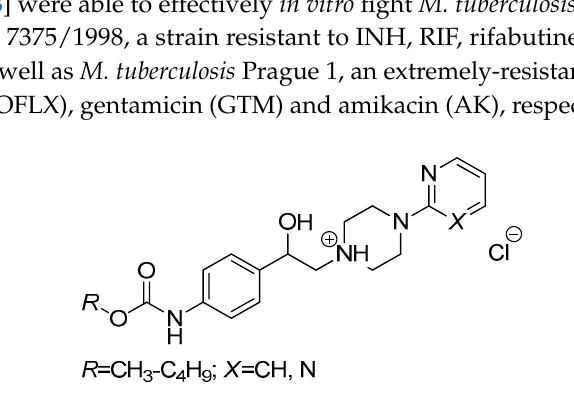
Figure 2. N -Arylpiperazine derivatives containing a 2-hydroxyethane-1,2-diyl connecting chain (a series MM ), which were in vitro screened against some mycobacterial strains [18].